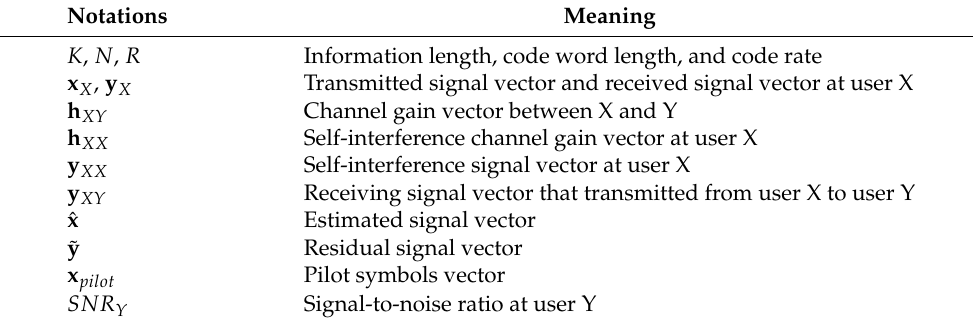
Table 1. List of